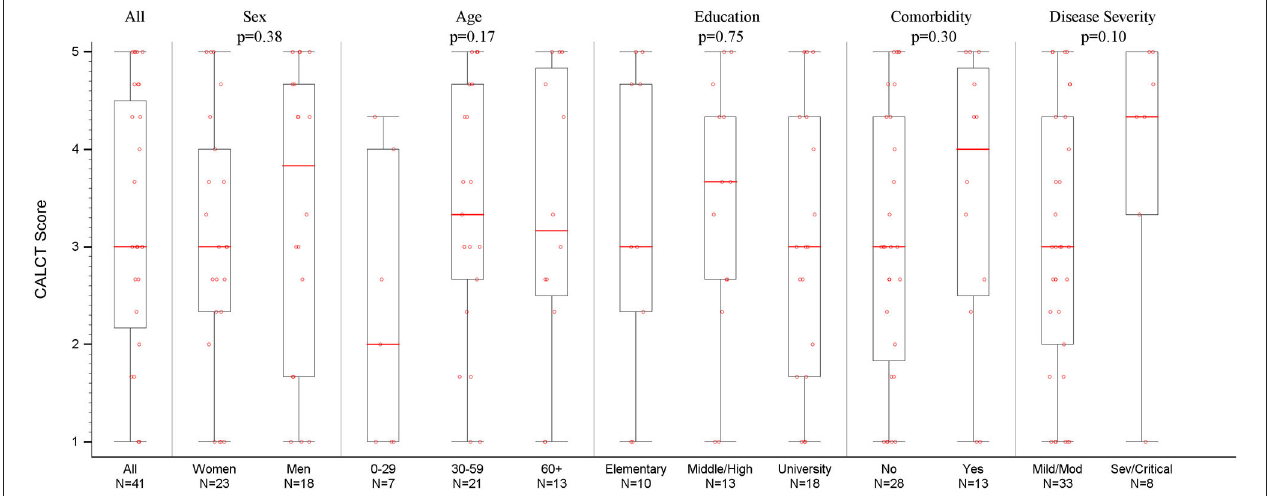
FIGURE 2 | COVID-19 as Life-changing Trauma (CALCT) Scores Overall, by Baseline Factors and Disease Severity. Psychological measures were assessed around 2 months from initial COVID-19 diagnosis. See Supplementary Table 4 for distribution of responses to the three CALCT survey items. Mod, Moderate; Sev,